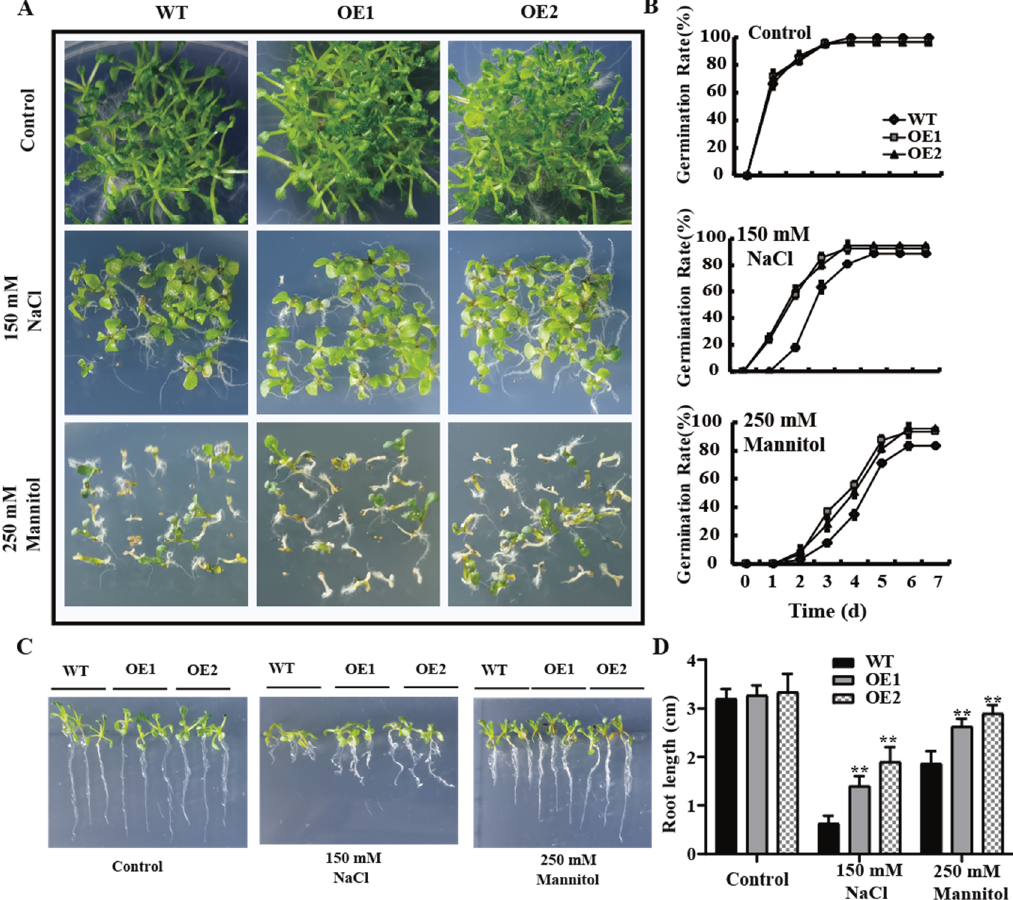
Figure 6. Germination rates and root lengths of the mature seeds harvested from the GmPAL1.1 overexpressing Arabidopsis (OE) lines and WT grown under normal condition. ( A ) Germination performance of the WT and OE lines under salt and drought stresses. The seeds of the WT and OE lines were grown for 7 d under 150 mM NaCl and 250 mM mannitol conditions, respectively. ( B ) Germination rates of WT and OE lines under salt and drought stresses. The germination rates were recorded on the seventh day. Each experiment was repeated three times with each replicate containing 50 seeds. ( C , D ) Root lengths of WT and OE lines under salt and drought stresses. The sterilized seeds of the OE lines and WT were grown on 1/2 MS media for 7 d, and then, the seedlings with the same root lengths and growth states were selected to grow for 5 d under salt and drought treatments. Values are mean ± SD of three biological replicates. ** indicated significant differences at 1% probability level between WT and transgenic Arabidopsis lines.